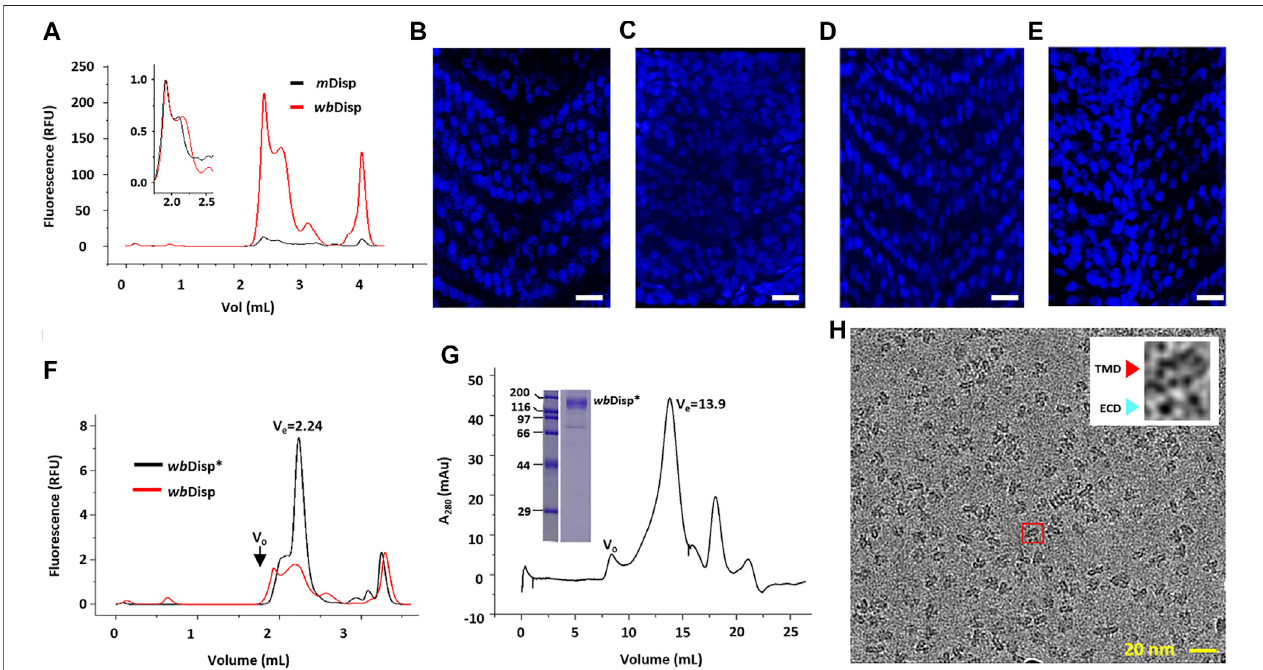
FIGURE1| ScreeningDisp homologsforstructuraland functional studies. (A) Fluorescence-detection sizeexclusion chromatography (FSEC) ofDisp frommouse ( m Disp) and water bear ( wb Disp). The void volume was 1.80 ml and the total volume was 4.20 ml. (B – E) Phenotype-rescue assay of wb Disp. The V-shaped somites seen in zebra fi sh (B) were lost upon the knockout of theendogenous disp gene (C) .This phenotype could be fully or partly rescued byintroducing m Disp (D) or wb Disp mRNA to the embryo (E) . Bar (cid:2) 40 μ m. The brightness and contrast of (C) were adjusted as a whole for better contrast. (F) FSEC of the wild-type wb Disp and wb Disp*whichcontainedseveraldeletions(seetext). (G) Preparativegel fi ltrationof wb Disp.Thevoidvolume(V 0 )isappropriatelylabeled.InsetshowstheSDS-PAGEof amain-peakfraction.MolecularstandardsforelectrophoresisareshownaskDaontheleft. (H) Atypicalcryo-EMmicrographof wb Disppuri fi edindigitonin.Insetshows the expanded image of a particle (red box) with a typical side view displaying a transmembrane domain (TMD) and two extracellular domains